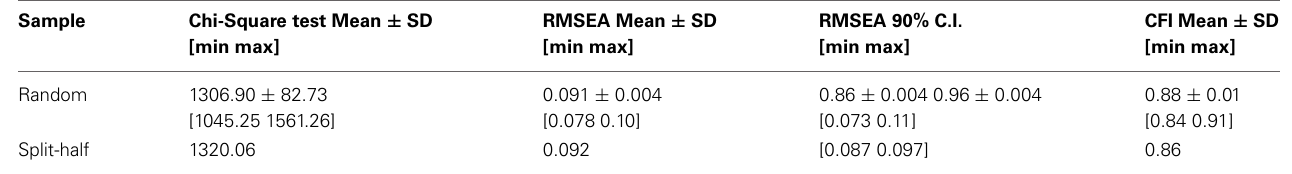
Table 4 | Averaged fit statistics of ( k = 1000) randomly selected sets of cases ( n = 400) for 7-factor resting-state cognition model compared to a split-half validation sample not used for EFA ( n = 400).